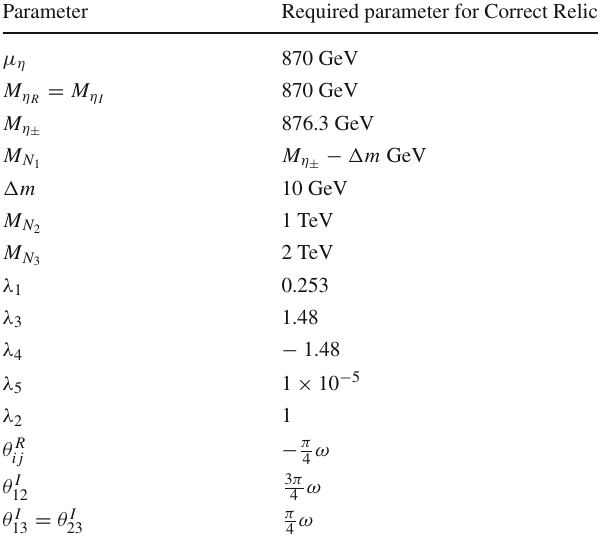
Table 5 The range of λ 5 allowed by phenomenological requirements of satisfying charged lepton flavour